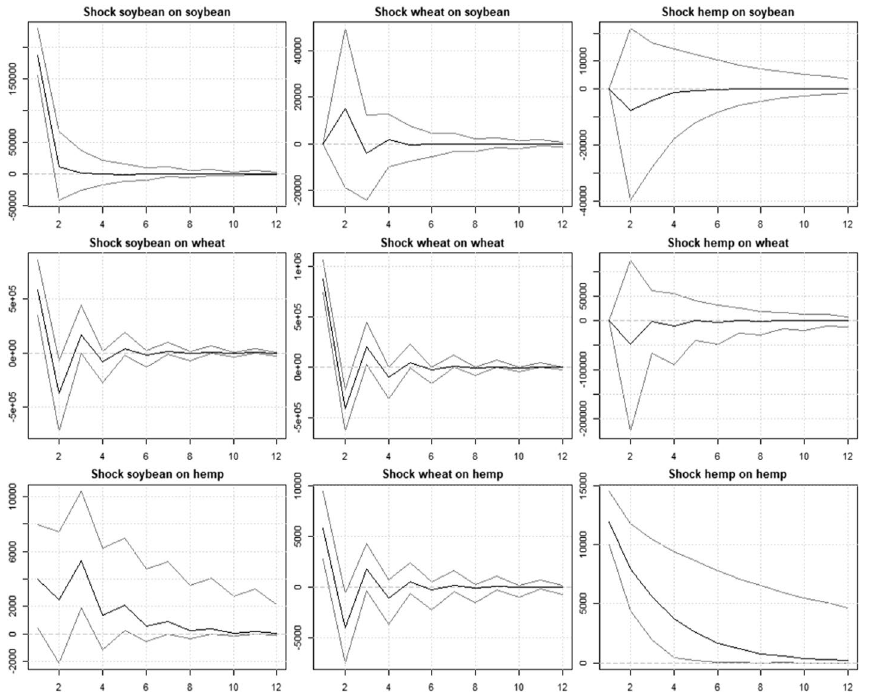
Fig. 3 Impulse response from soybean, wheat, and hemp with 90% confidence